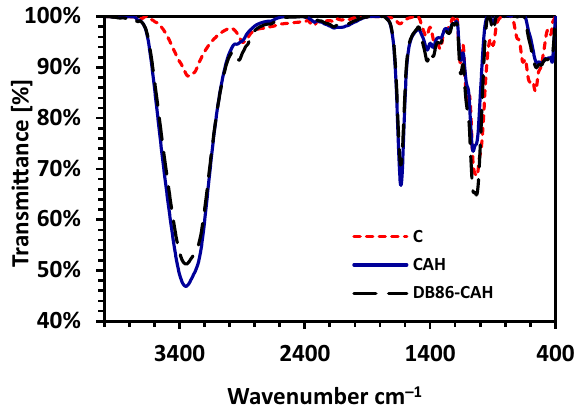
Figure 2. FT-IR analysis of Cellulose (C), Cellulose Hydrogel (CAH), and DB86 dye-Cellulose Hydrogel (DB86-CAH).